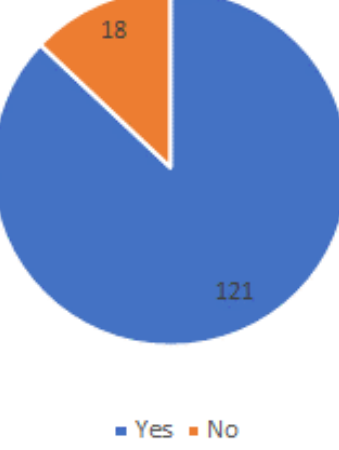
Figure 7. Access and use of the Internet.